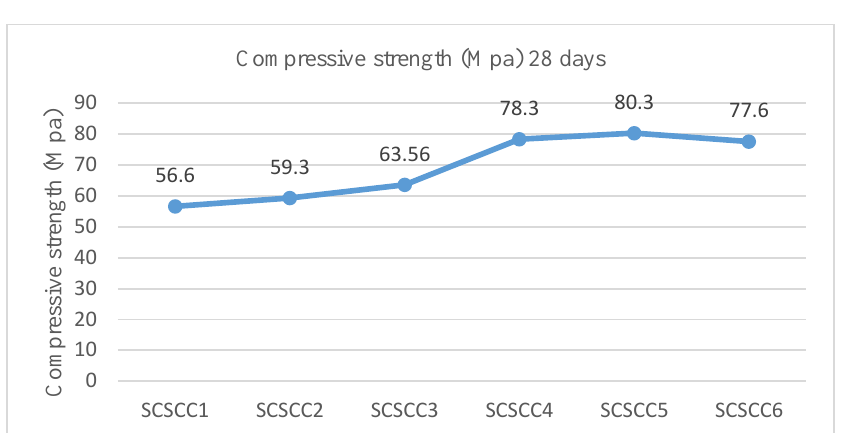
Fig. 18. Compressive strength of SCSCC mixes @28 days.